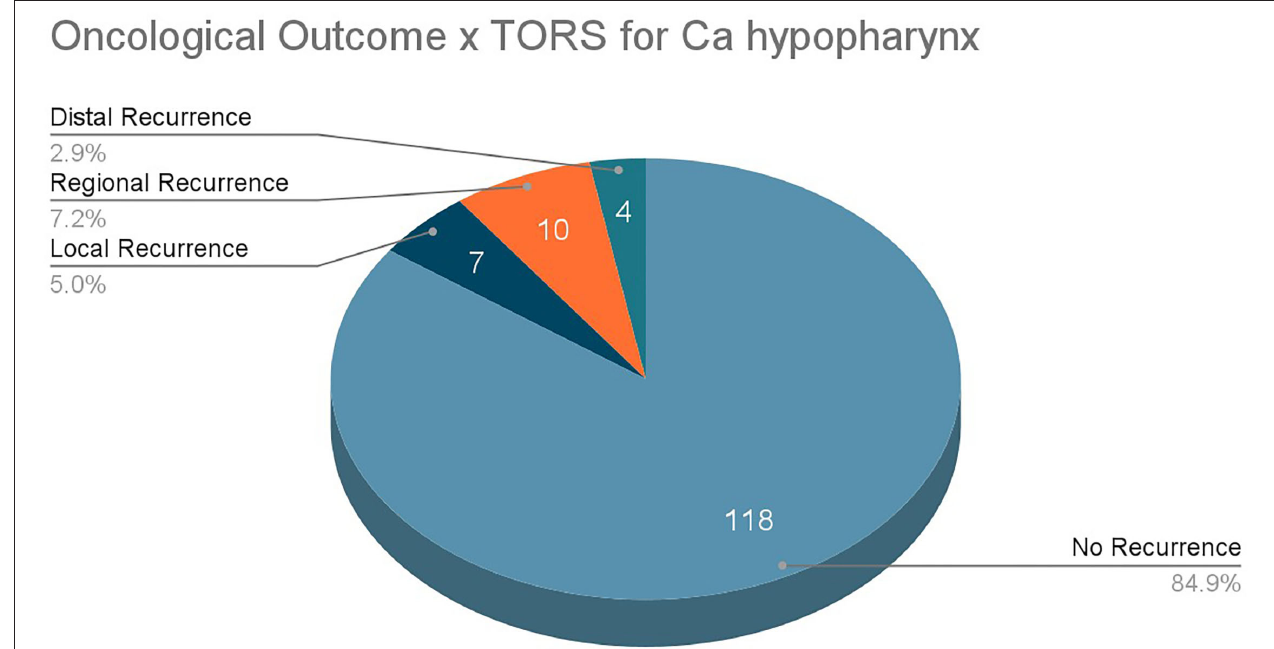
FIGURE 4 | Oncological outcomes in TORS